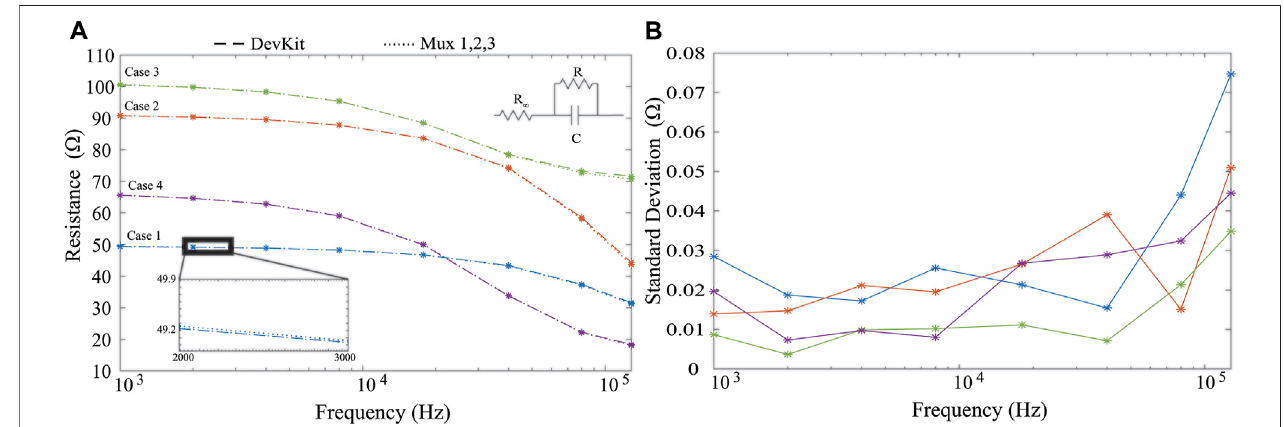
FIGURE2| MAX30001developmentkit(dashed)andwearablesystem(hatched) (A) resistancemeasurementsfromfourcasesof2 R -1 C modelsand (B) standard deviation of measurements across all analog multiplexer con fi gurations.